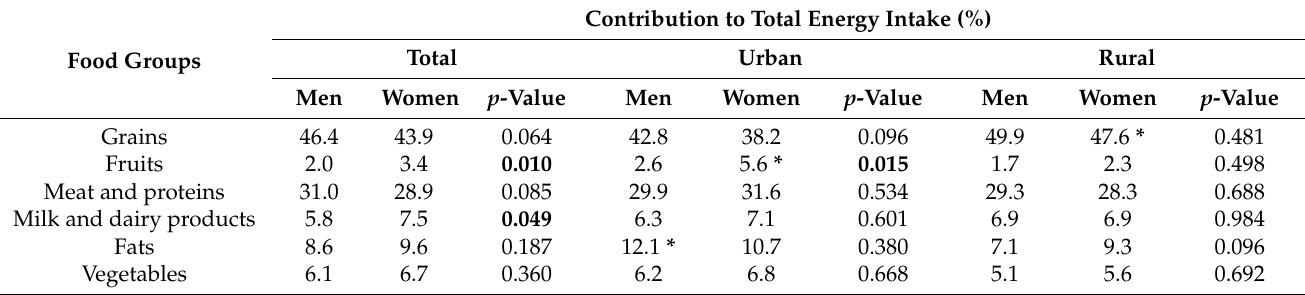
Table 2. Contribution of food groups to total energy intake by gender and living area.